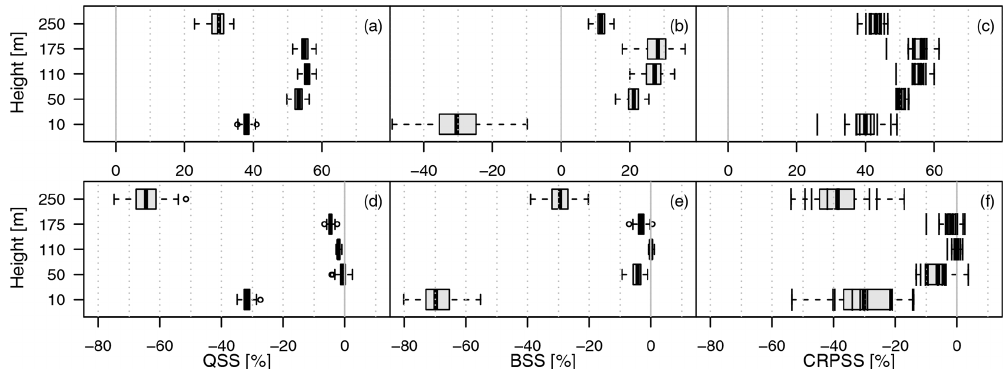
Figure 6. Same as in Fig. 5 but for (a–c) the leave-out model against climatology and (d–f) against the layer-wise